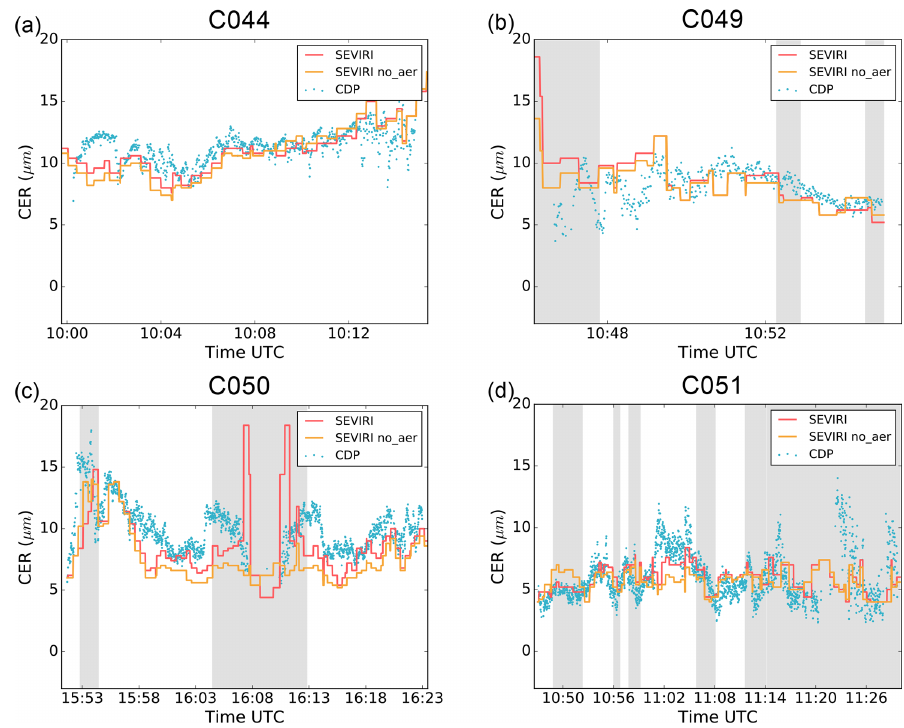
Figure 10. Comparison of the CER measured by the CDP during the straight level run through clouds from flights C044 (a) , C049 (b) , C050 (c) and C051 (d) and the collocated SEVIRI retrievals with and without taking into account the absorption of aerosol above clouds. The grey areas correspond to the SEVIRI pixels that are rejected because of the filters on cloud inhomogeneity, cloud edges and/or unsatisfying fit of the measurements by the forward